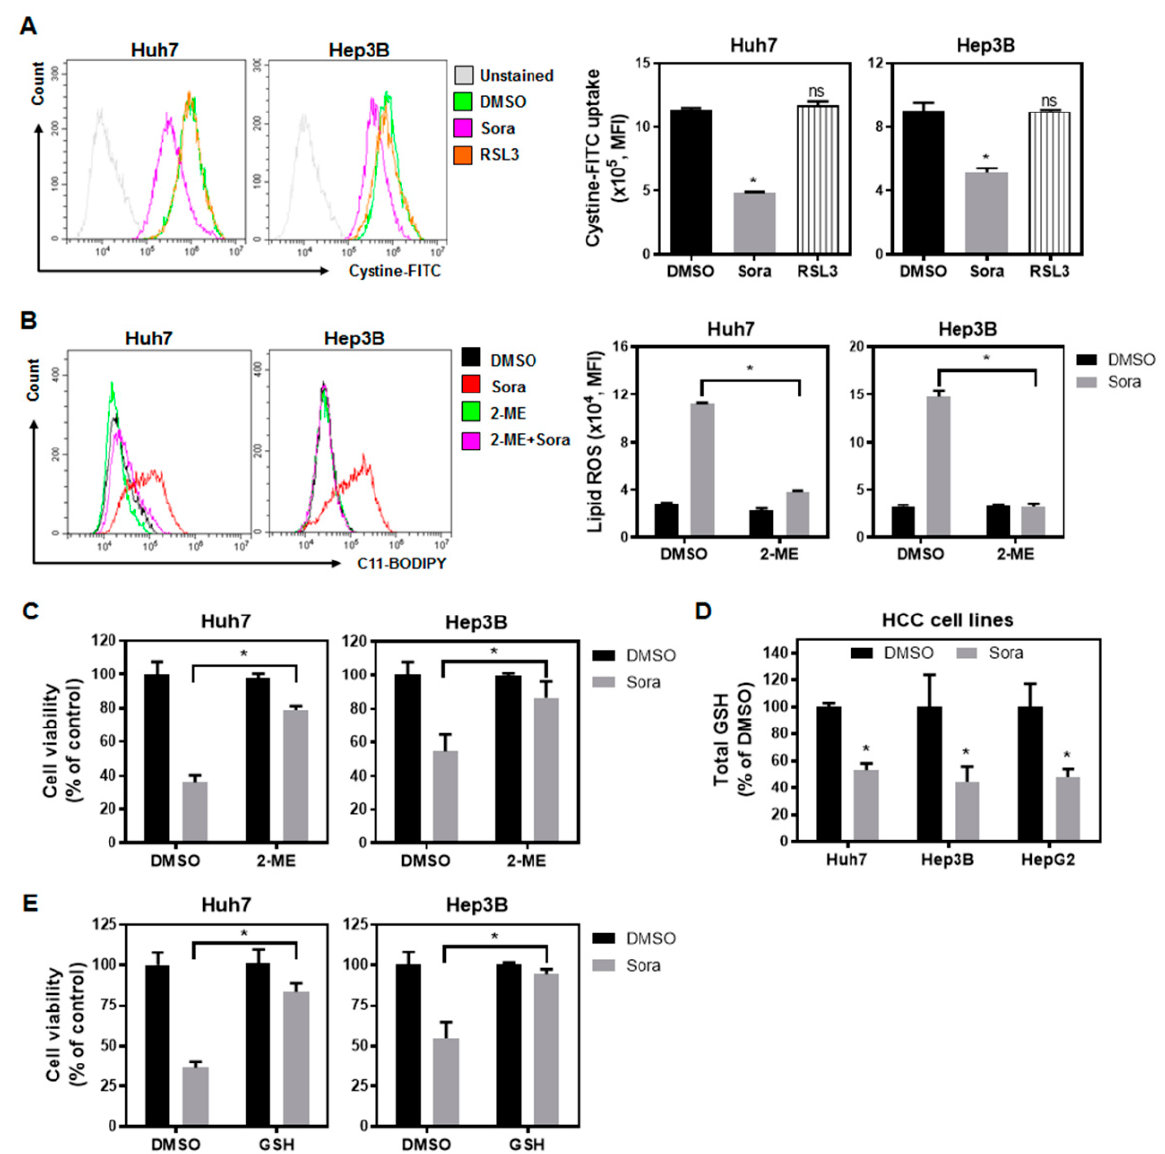
Figure 2. Sorafenib treatment inhibits system-Xc − -regulated cystine uptake and elevates lipid reactive oxygen species (ROS) levels, culminating in ferroptotic cell death: ( A ) Sorafenib inhibited cys- tine–FITC intake, whereas Ras-selective lethal small molecule 3 (RSL3)—a GPX4 inhibitor—did not. Huh7 cells and Hep3B cells were cultured in DMSO (0.1%), sorafenib (2.5 µM for Huh7 cells and 5 µM for Hep3B cells), or RSL3 (2.5 µM) for 16 h. After treatment, the cells were subjected to flow cytometry analyses. ( B ) The addition of β -Mercaptoethanol (2-ME) (50 µM) suppressed sorafenib (5 µM)-induced lipid ROS levels and ( C ) restored HCC cell viability. ( D ) Sorafenib treatment lowered the intracellular levels of total glutathione (GSH) in the three HCC cell lines. Cells were exposed to sorafenib (2.5 µM for Huh7 and HepG2 cells; 5 µM for Hep3B cells) for 16 h and then harvested for measurement of their GSH content. ( E ) The addition of reduced GSH (2 mM) to the medium con- taining 5 µM sorafenib decreased the cytotoxicity of sorafenib against Huh7 and Hep3B cells. MTT assays were conducted to determine the cell viability. Columns: mean; bars: SD (n ≥ 3). Statistical analysis was conducted by employing the Mann–Whitney U test (*, p < 0.05).